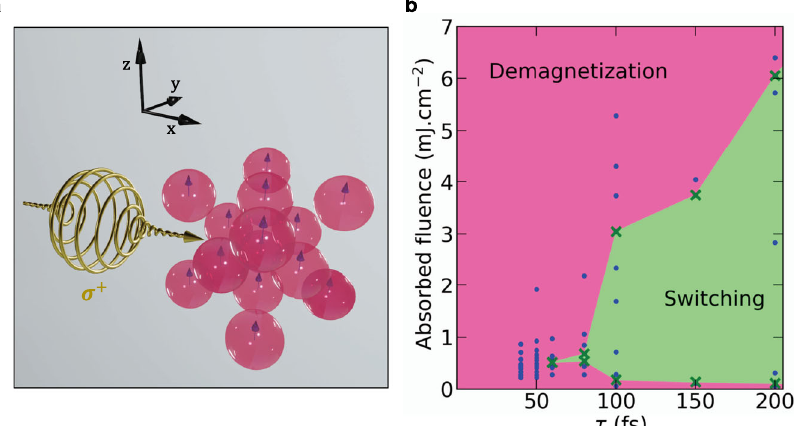
Fig. 1 Parameter space for single-pulse all-optical switching of bulk Ni. a Schematic representation of a circular light pulse interacting with an fcc bulk material with initial magnetization pointing along the + z direction. b Laser parameter phase diagram for bulk Ni as a function of the laser pulse width τ and absorbed fl uence. The dots indicate all the performed calculations, and the crosses mark the identi fi ed